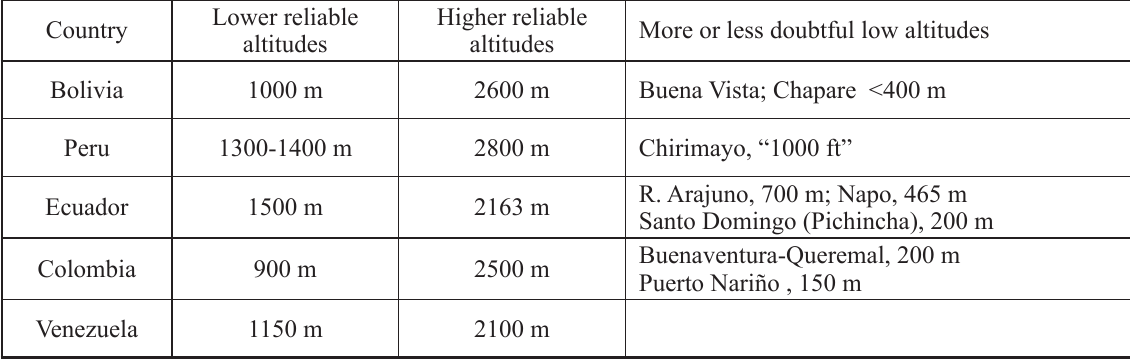
Table 2. Altitudinal range of the Eryphanis zolvizora group.